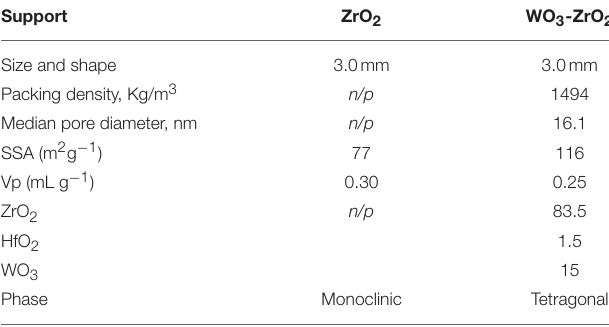
TABLE 1 | Properties of untreated catalyst